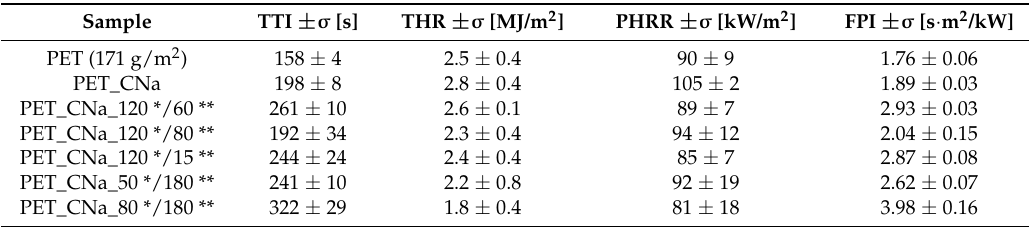
Table 2. Combustion data of PET treated previously by plasma and sodium cloisite by cone calorimetry (35 kW/m 2 )